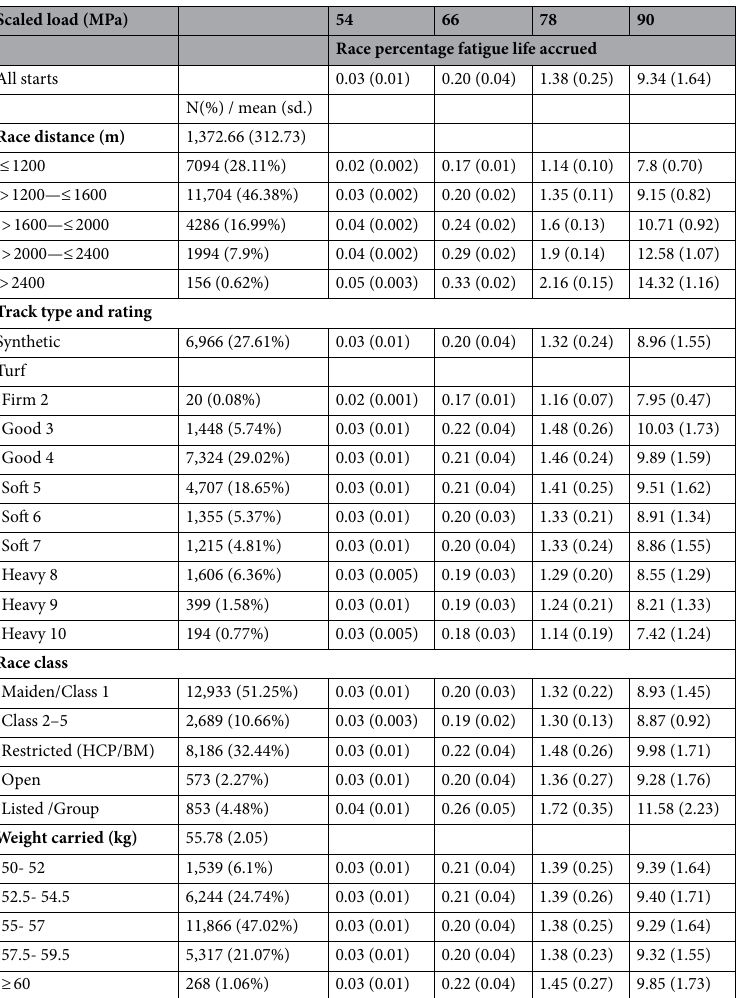
Table 1. Estimated percentage of bone fatigue life accrued over n = 25,234 Thoroughbred race starts in Tasmania, Australia as means (sd.) based on speed and stride data obtained by GPS and accelerometer. Results are stratified by race distance of race and track surface type and rating (firmest to softest). Loads were estimated using varying pressure across a joint surface according to pre-determined experimental joint loads. For categorical variables, number of starts (N) and percentage of starts are presented. Continuous variables are presented as mean (sd.), stratified by experimental load indicating variation in race percentage fatigue